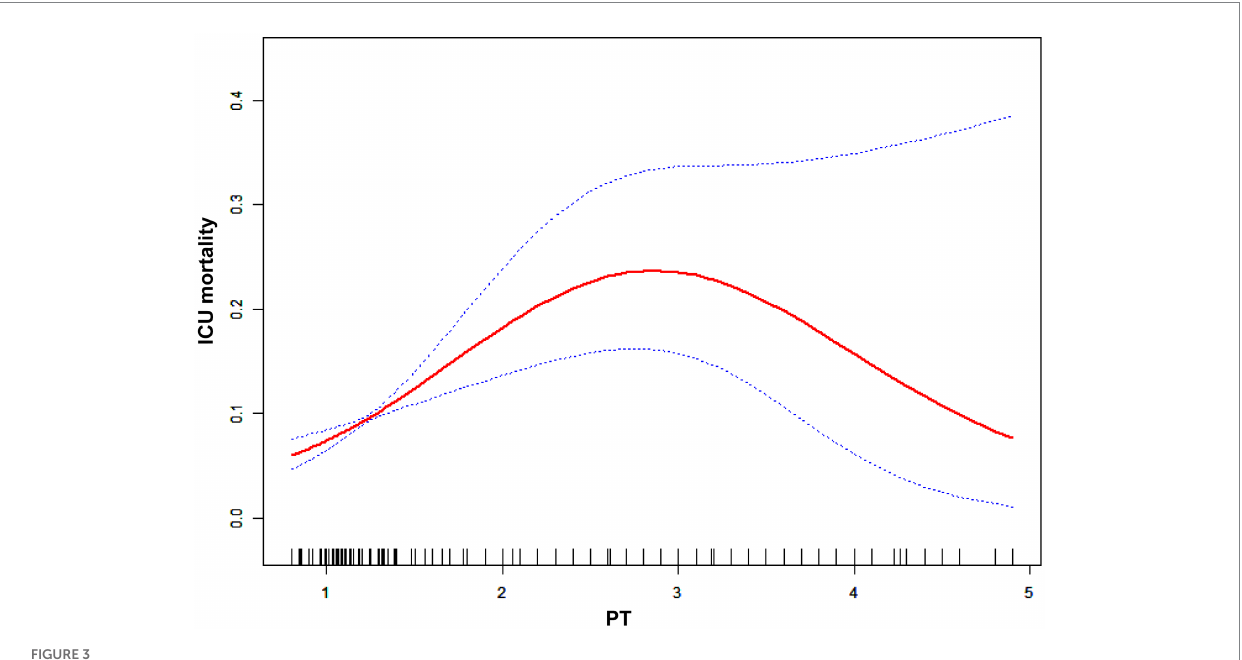
FIGURE 3 Nonlinear relationship between the PT-INR and in-hospital